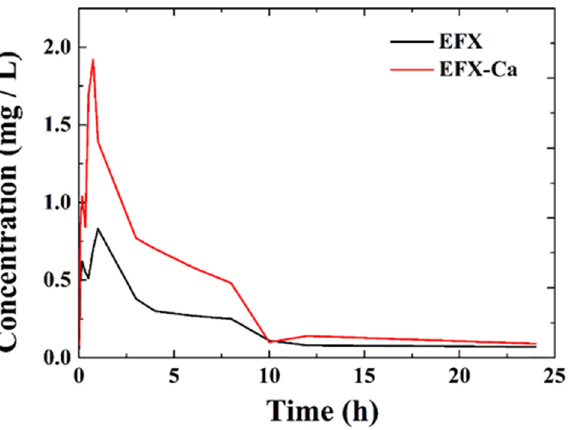
Figure 4. Histopathological images under 40× magnification on the main organs from the dead mice after the oral administration of EFX, EFX-Na, and EFX-Ca, in which the histologic tissue slices of ( a ) heart, ( b ) liver, ( c ) spleen, ( d ) lung, ( e ) kidney, ( f ) large intestine, and ( g ) small intestine were stained and visualized. Number 0, 1, 2, 3 indicates the effect of EFX, EFX-Ca and EFX-Na for each organ, respectively.